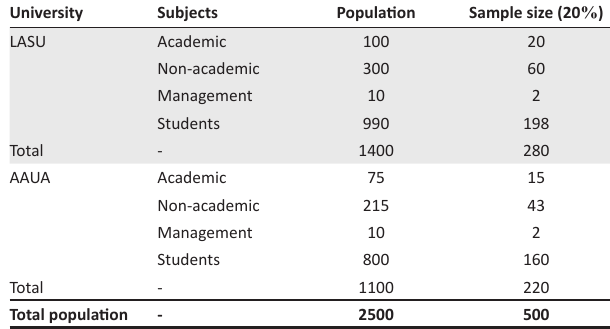
TABLE 1: Total population and sample size of the